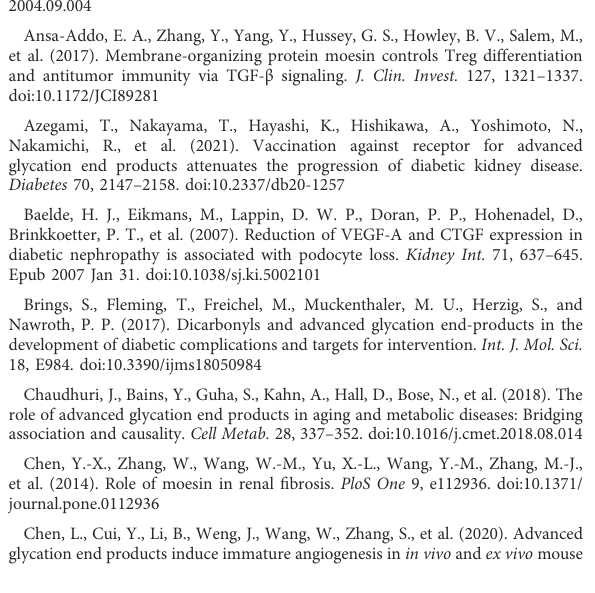
SUPPLEMENTARY FIGURE S1 Expression of CD34 and the content of Col-I were not changed in the kidney tissue from AGE-BSA-treated mice. The expression of CD34 (A) and the content of Col-I (B) in the kidney tissue from AGE-BSA-treated mice for 1 m and 6 m were detected by immunoblotting. n =4; ns, no signi fi cance. SUPPLEMENTARY FIGURE S2 The ef fi ciency of RAGE knockout in mice. (A) Genotyping was conducted using mouse tail tissue with primers of 5 ′ -CCAGAGTGACAACAGAGC AGAC-3 ′ (primer1); 5 ′ -CCTCGCCTGTTAGTTGCCCGAC -3 ′ (primer 2) and 5 ′ -GGTCAGAACATCACAGCCCGGA -3 ′ (primer 3), respectively. (B) RAGE expression was detected by immunoblotting in kidney tissue from WT and RAGE ( − / − ) mice. n = 4, * p <